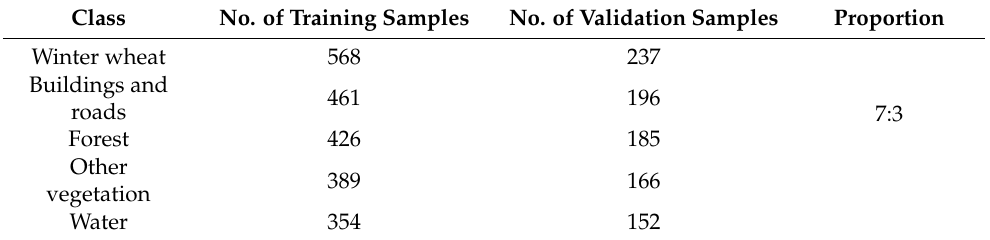
Table 2. Number and proportion of samples used for training and